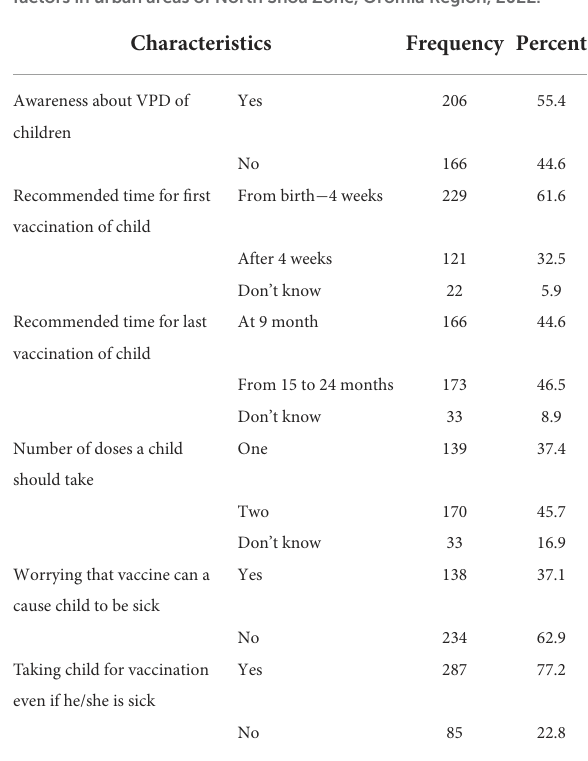
TABLE 3 Distribution of mothers’ awareness and perception-related factors among study participants for MCV2 vaccination and associated factors in urban areas of North Shoa Zone, Oromia Region,